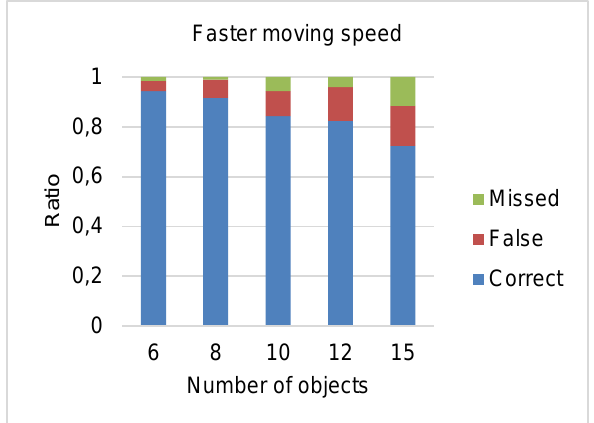
Figure 5: Average object-specific orientation error for all interfaces and the two movement speeds. Green dashed line refers to orien- tation error of slower moving speed. Red line refers to orientation error of faster moving speed.